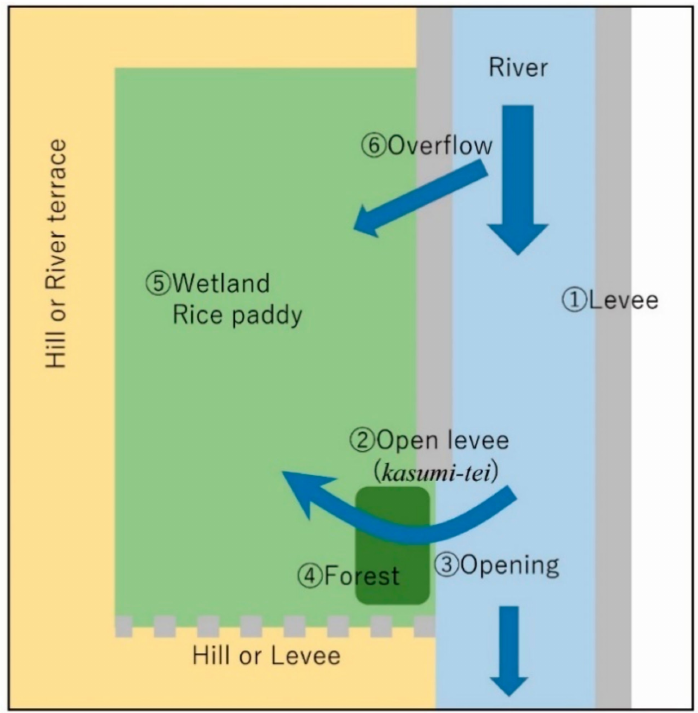
Figure 17. Open levee